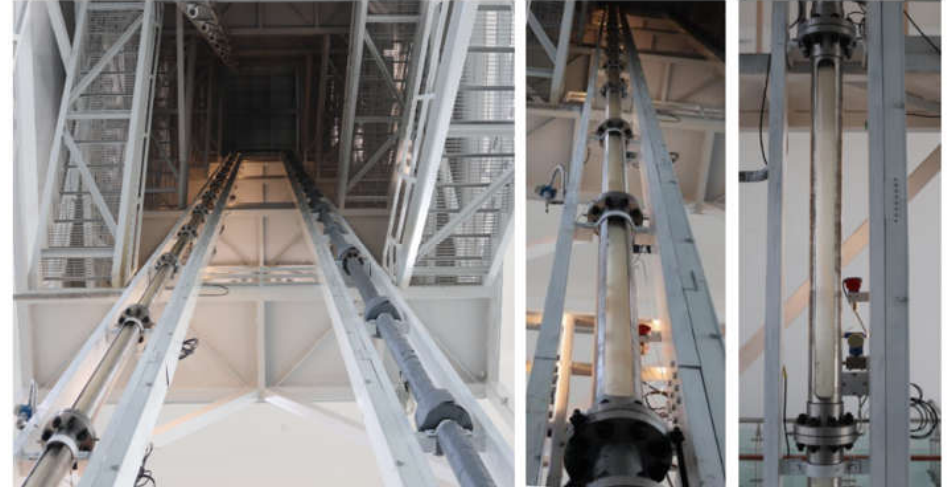
Figure 7. Vertical pipe transport system.